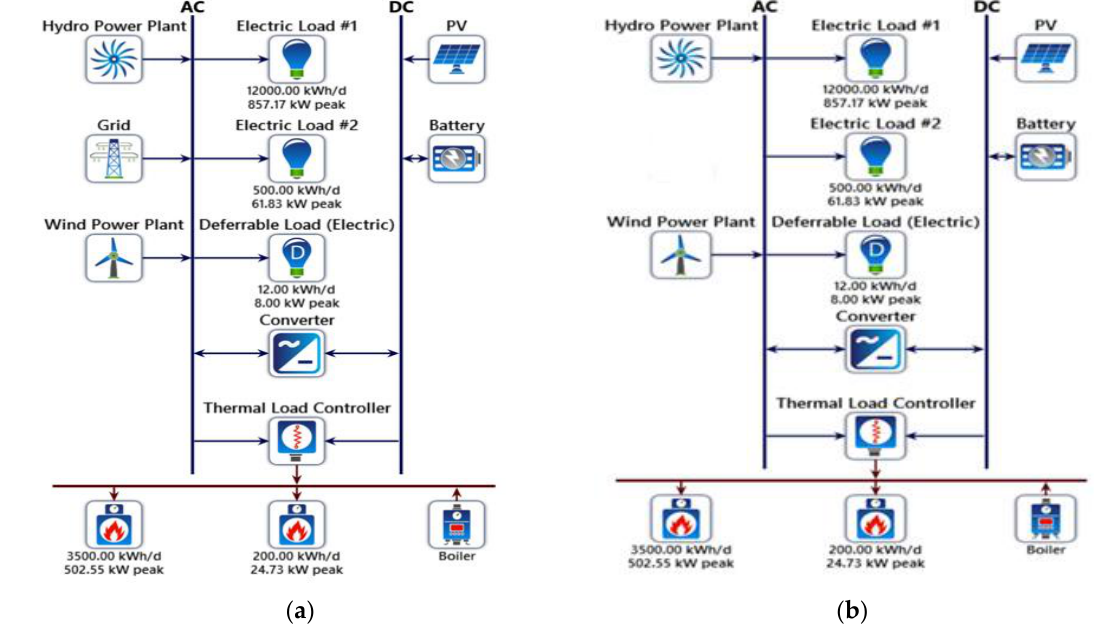
Figure 9. ( a ) Small scale stand-alone grid-connected renewable energy sources-based energy system; ( b ) Small scale stand-alone Off-grid renewable energy sources-based energy system.